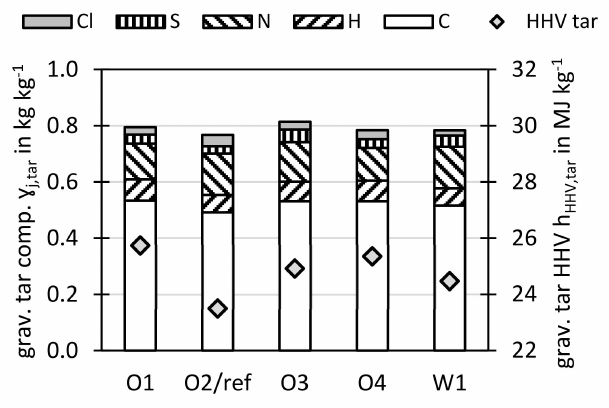
Figure 10. Elemental analysis and heating values of gravimetric